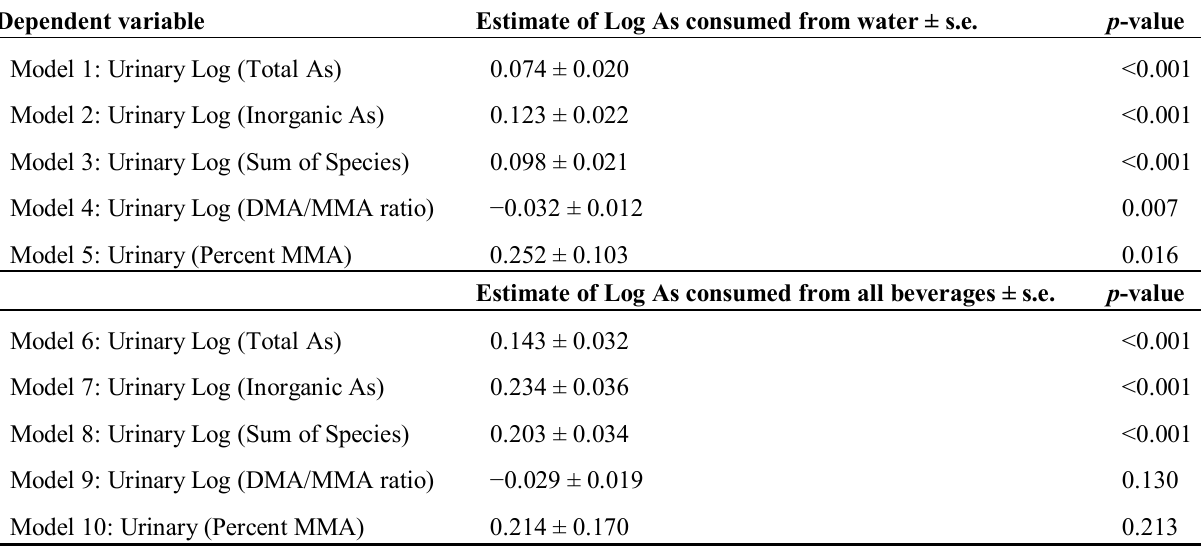
Table 6. Random Effect Models Depicting the Association between Urinary Metabolite Concentrations and Arsenic Consumed from Drinking Water and Beverages